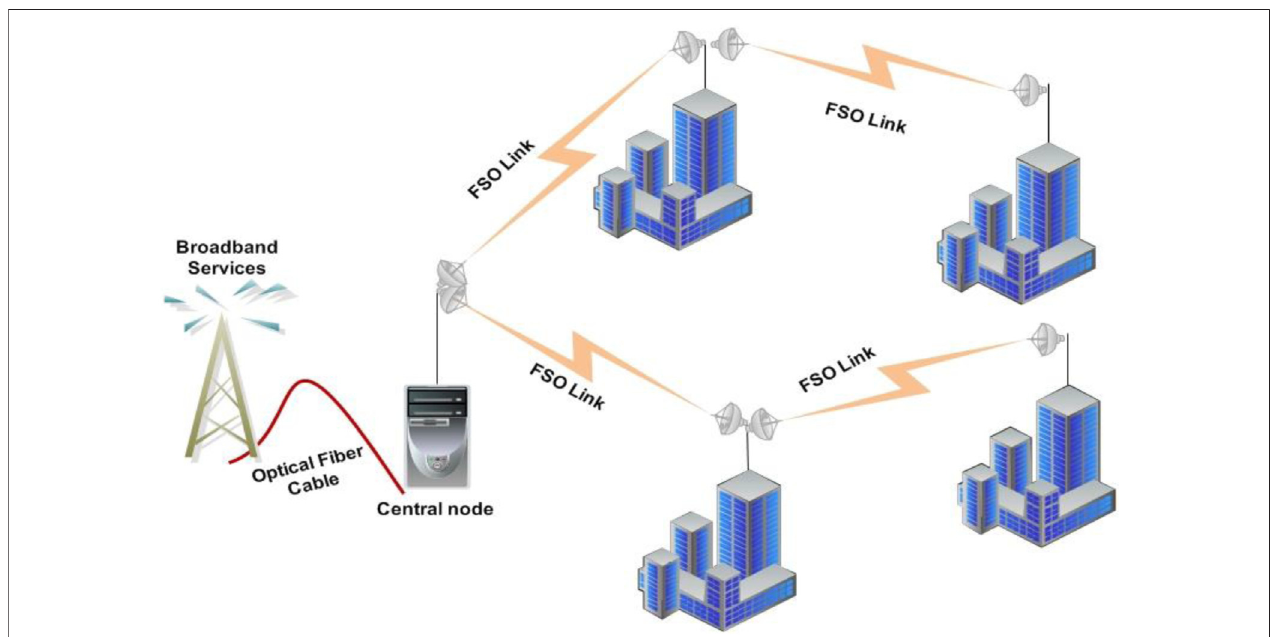
FIGURE 1 | Architecture of FSO for broadband